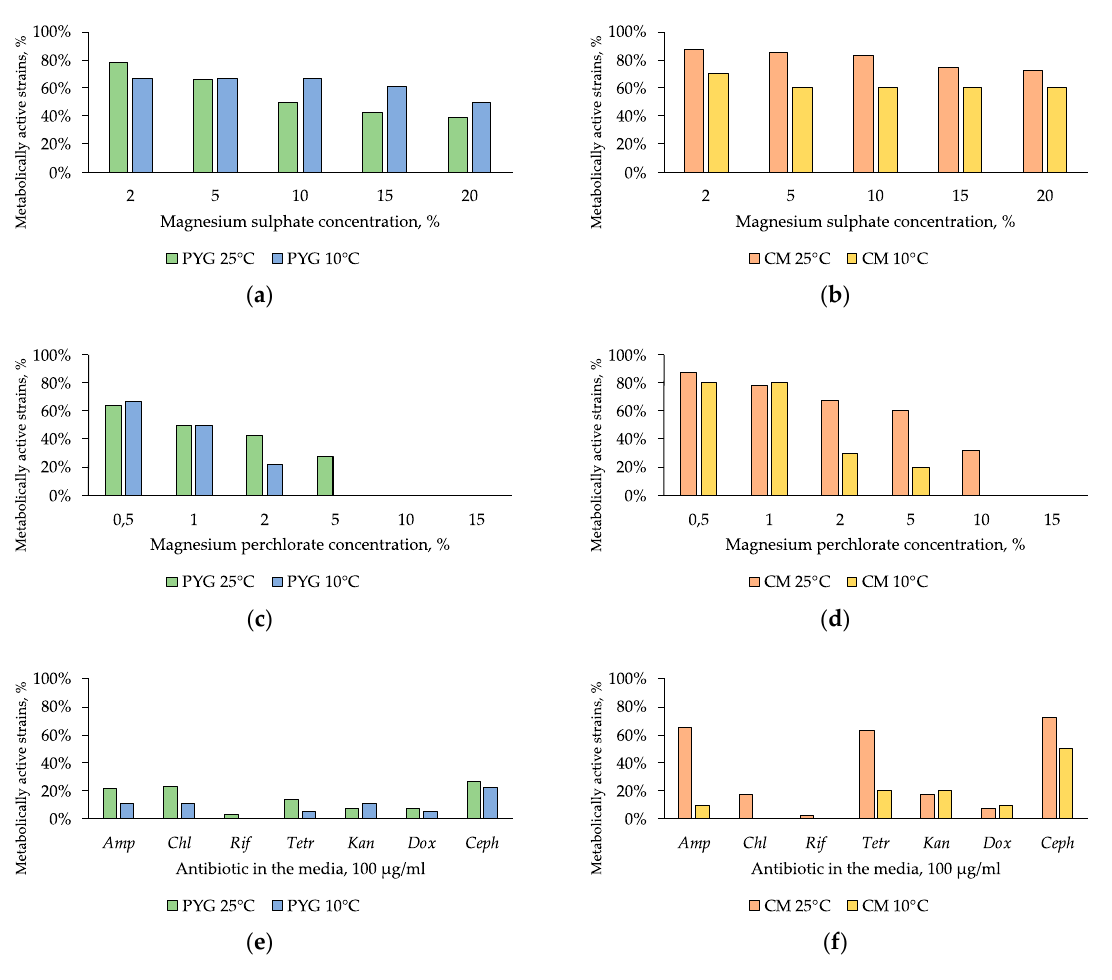
Figure 8. Isolated strains resistance to: ( a ), ( b )—magnesium sulphate; ( c ), ( d )—magnesium perchlorate, ( e ), ( f )—antibiotics. Left column: strains isolated on PYG medium; right column—strains isolated on CM medium. Amp —ampicillin; Chl —chloramphenicol; Rif —rifampicin; Tetr —tetracycline; Kan —kanamycin; Dox —doxycycline; Ceph —cephalexin.